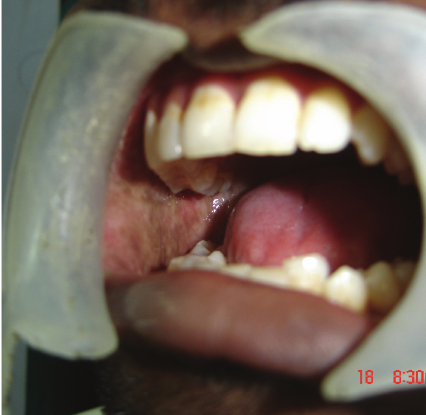
Figure 1: Bilateral oral submucous fibrosis (preop).